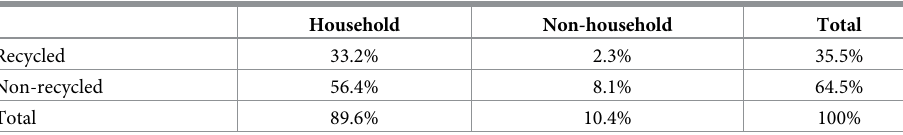
Table 1. Waste supply by